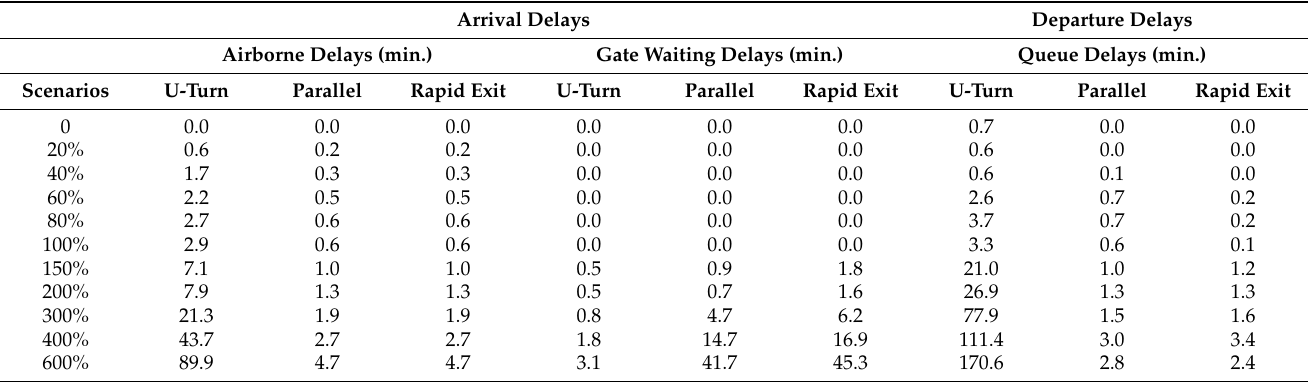
Table 10. Average delays per